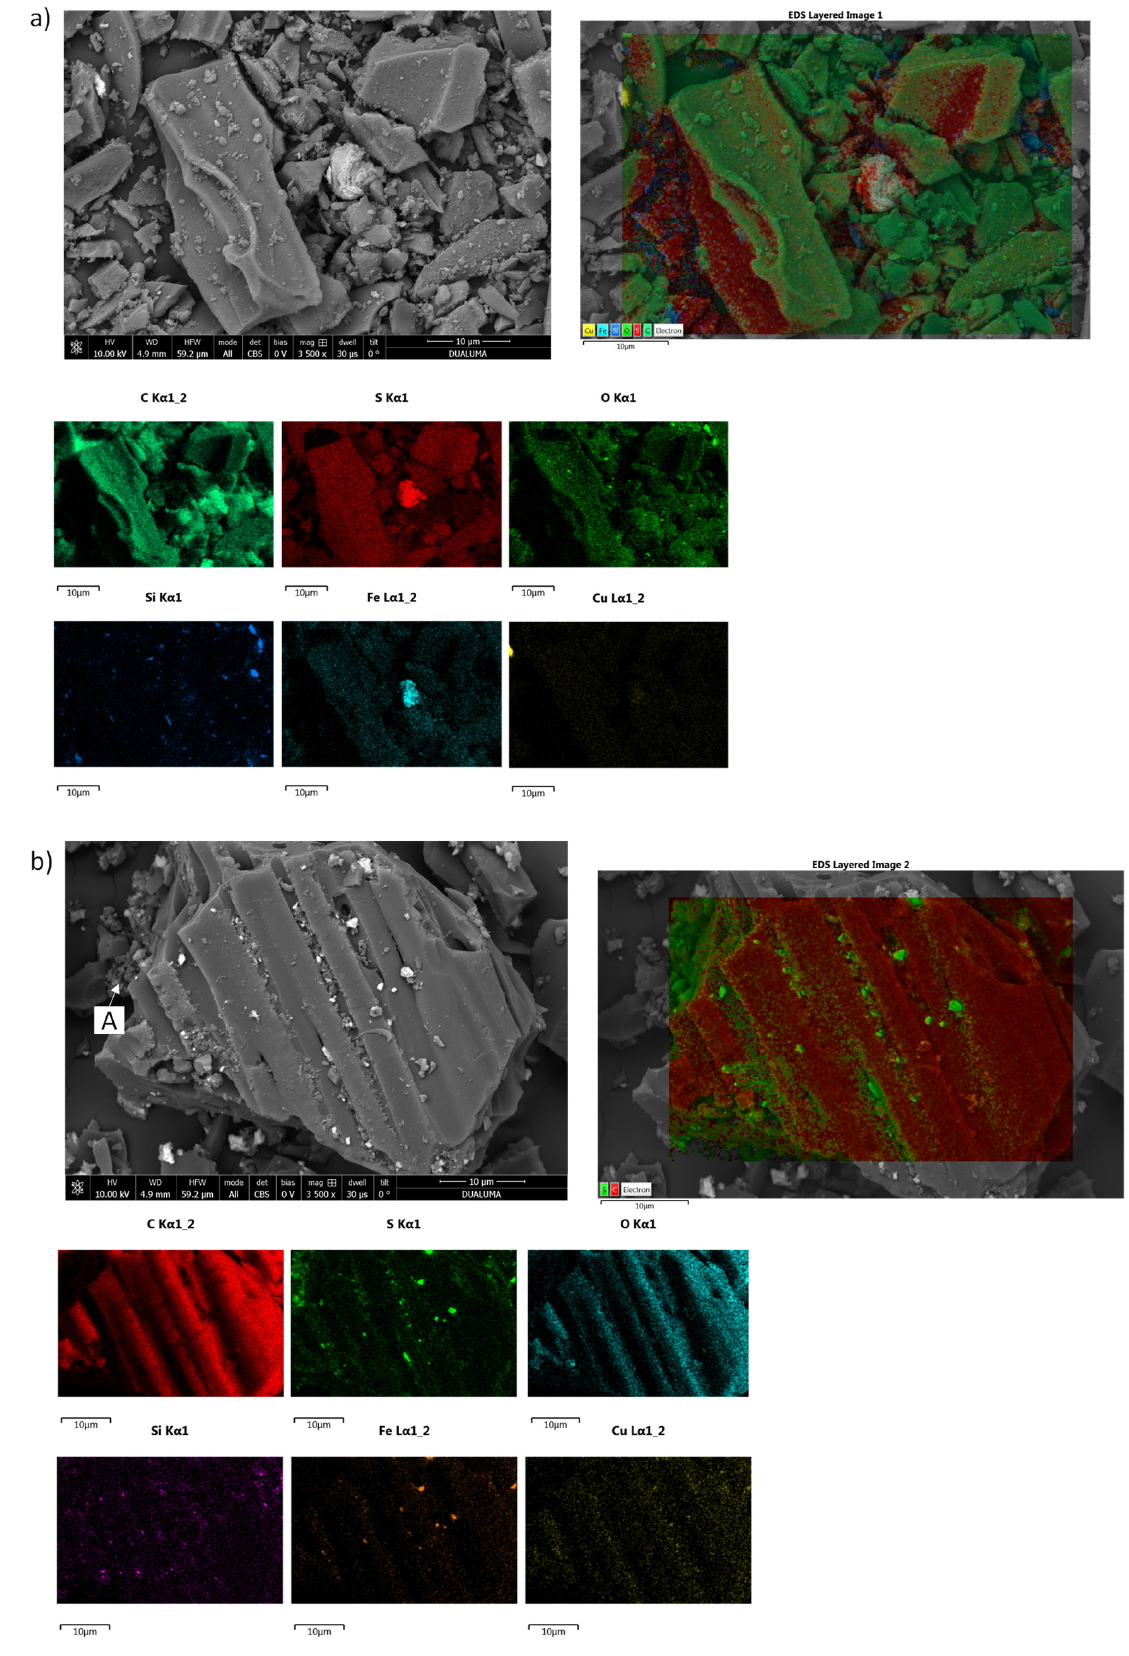
Figure 8. SEM-EDS images of CC ( a ) and BC ( b ) . A: elemental sulfur. The addition of BC leads to a final residue with characteristics different from those obtained in the presence of CC. With BC, large amounts of sulfur were observed (43% in